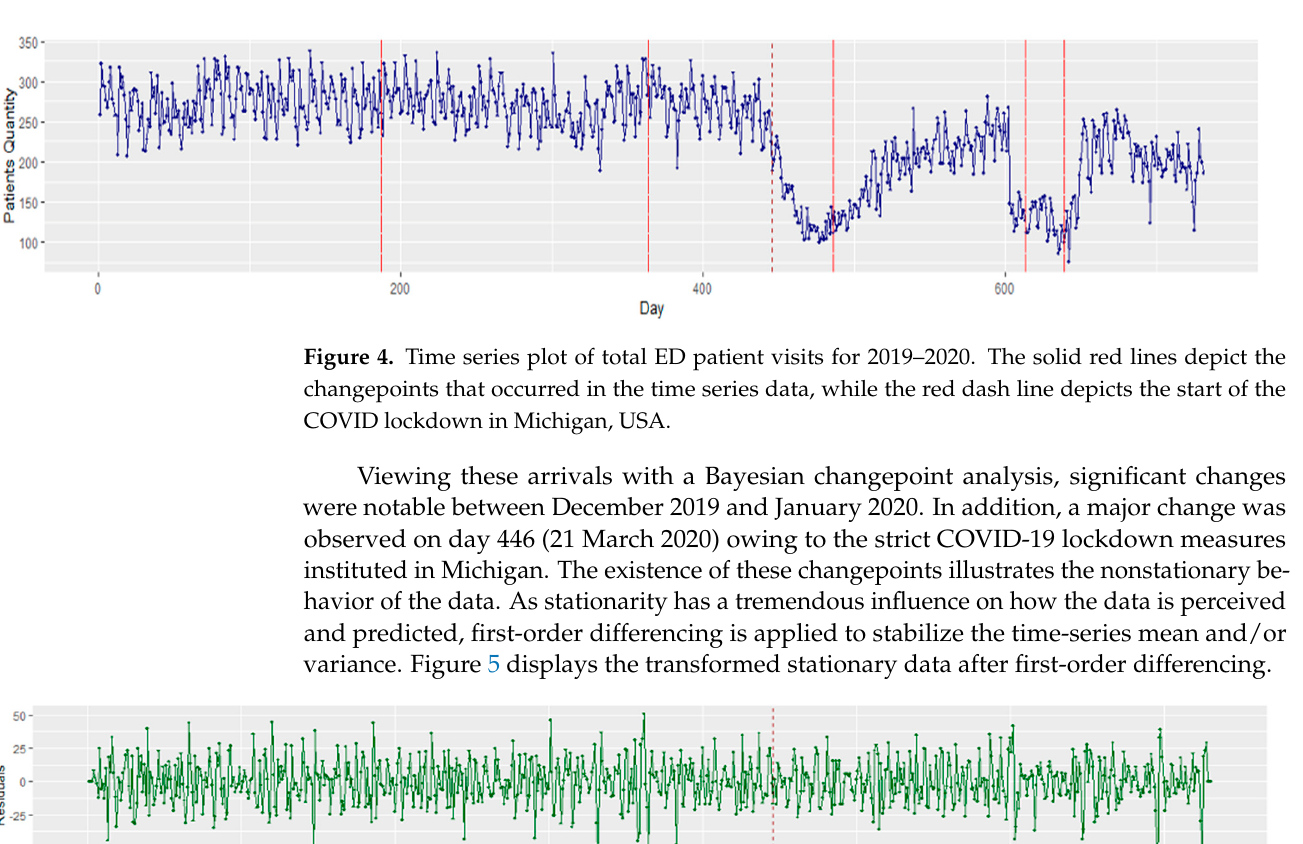
Figure 3. The ED patient arrivals for the two years. The figure depicts: ( A ) The average arrivals for 2019; ( B ) The average arrivals for 2020; ( C ) The weekday arrivals for 2019; and ( D ) The weekday arrivals for 2020.